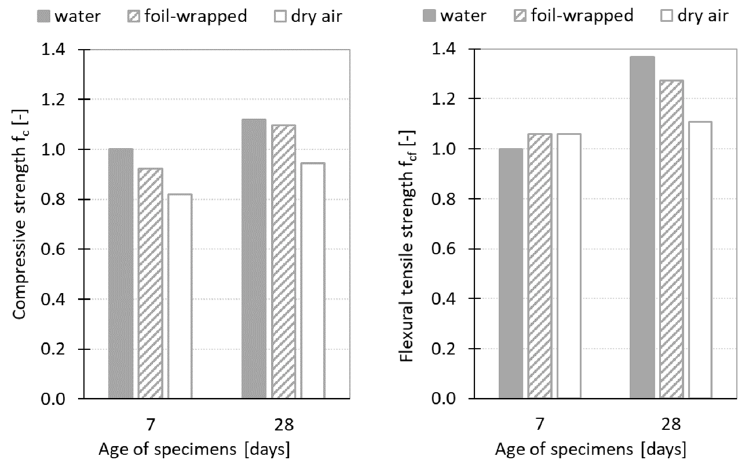
Figure 6. Characteristics of hardened Self-Compacting High-Performance Concrete: Relative values of compressive strength and tensile strength: 1 = water cured specimens at the age of 7 days.